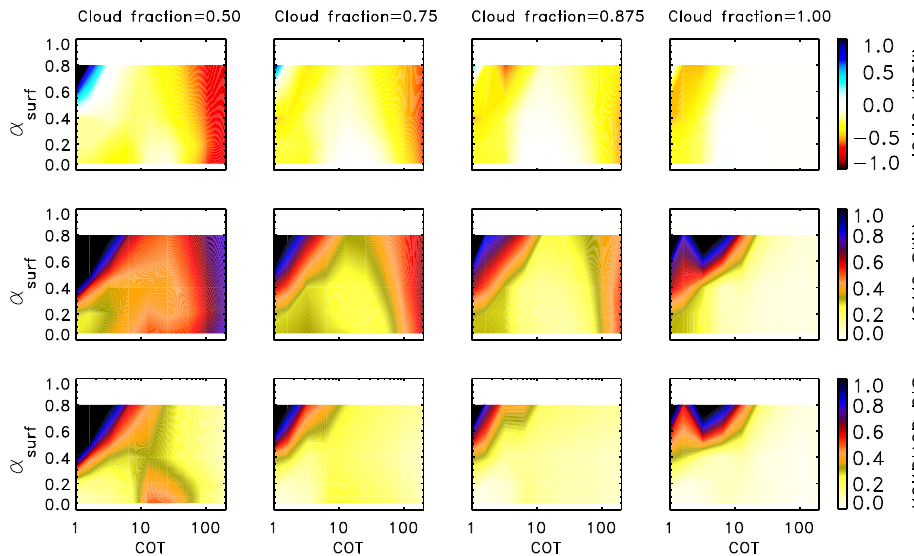
Fig. 7. As Fig. 5, except the results are for pure liquid water clouds, and the columns indicate different values of the cloud fraction.